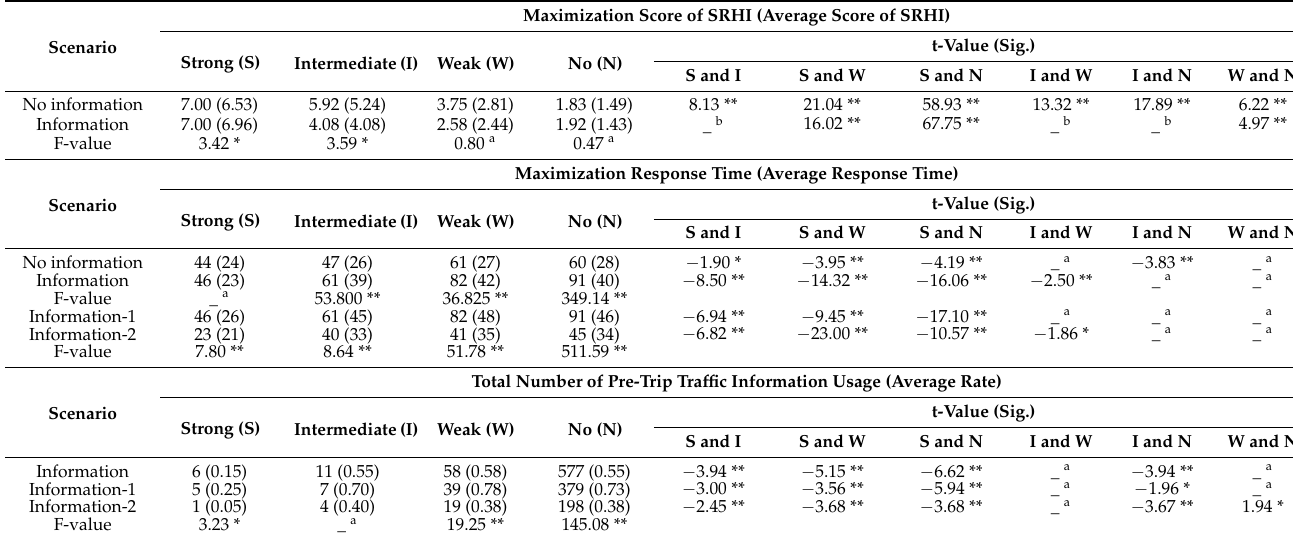
Table 4. ANOVA results (between and within group